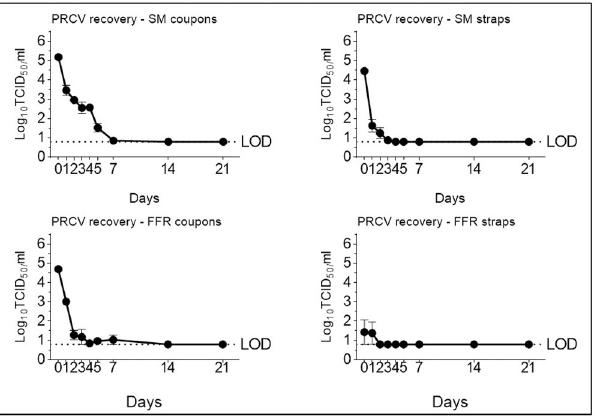
Fig 2. Recovery of porcine respiratory coronavirus (PRCV) after elution from filtering facepiece respirators (FFRs) and surgical masks (SMs) kept at room temperature (20˚C) over time. PRCV infectivity was analysed in swine testicular cells. The cell culture limit of detection (LOD) was 0.80 log10 TCID 50 /mL (6.31 × 10 0 TCID 50 /mL).